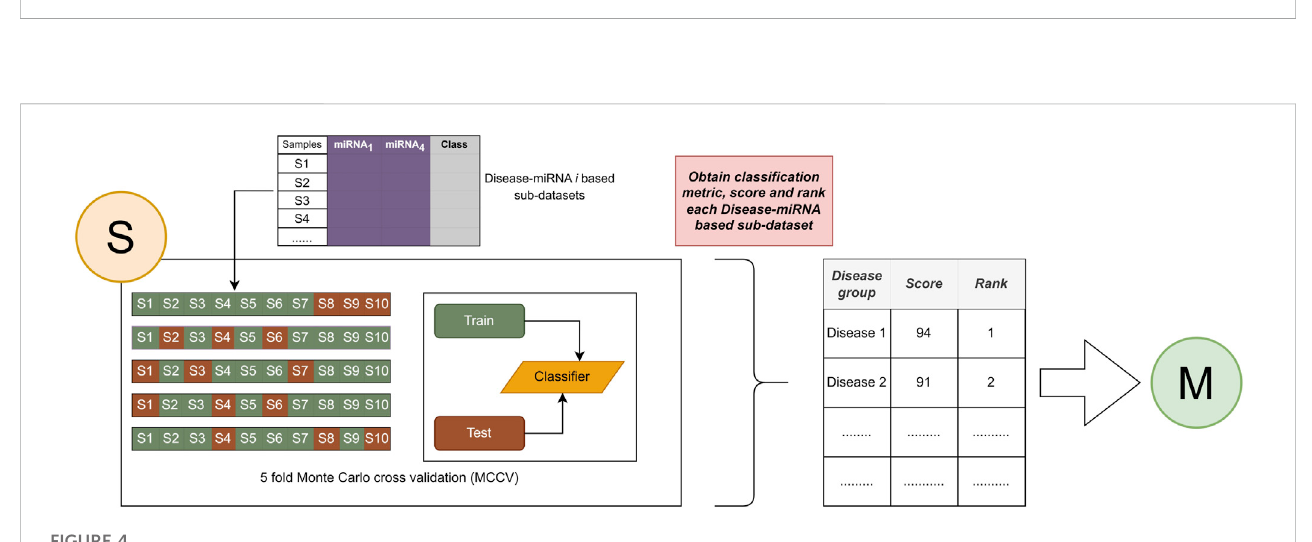
FIGURE 3 The distributions of miRNA in each of the groups. Y -axis is the number of miRNAs in a group and X -axis represents the group size which is binned in 10 intervals.